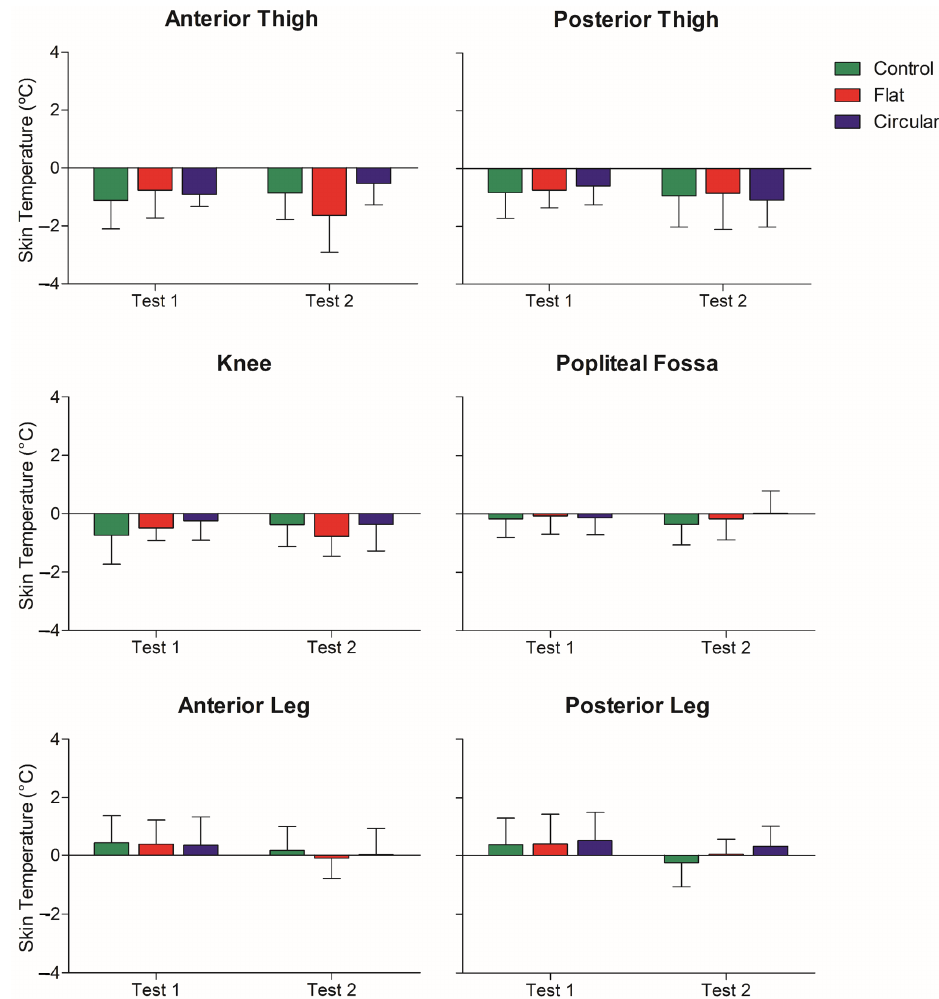
Figure 6. Maximum skin temperature Variation (Mean ± SD) for each region of interest in all groups.